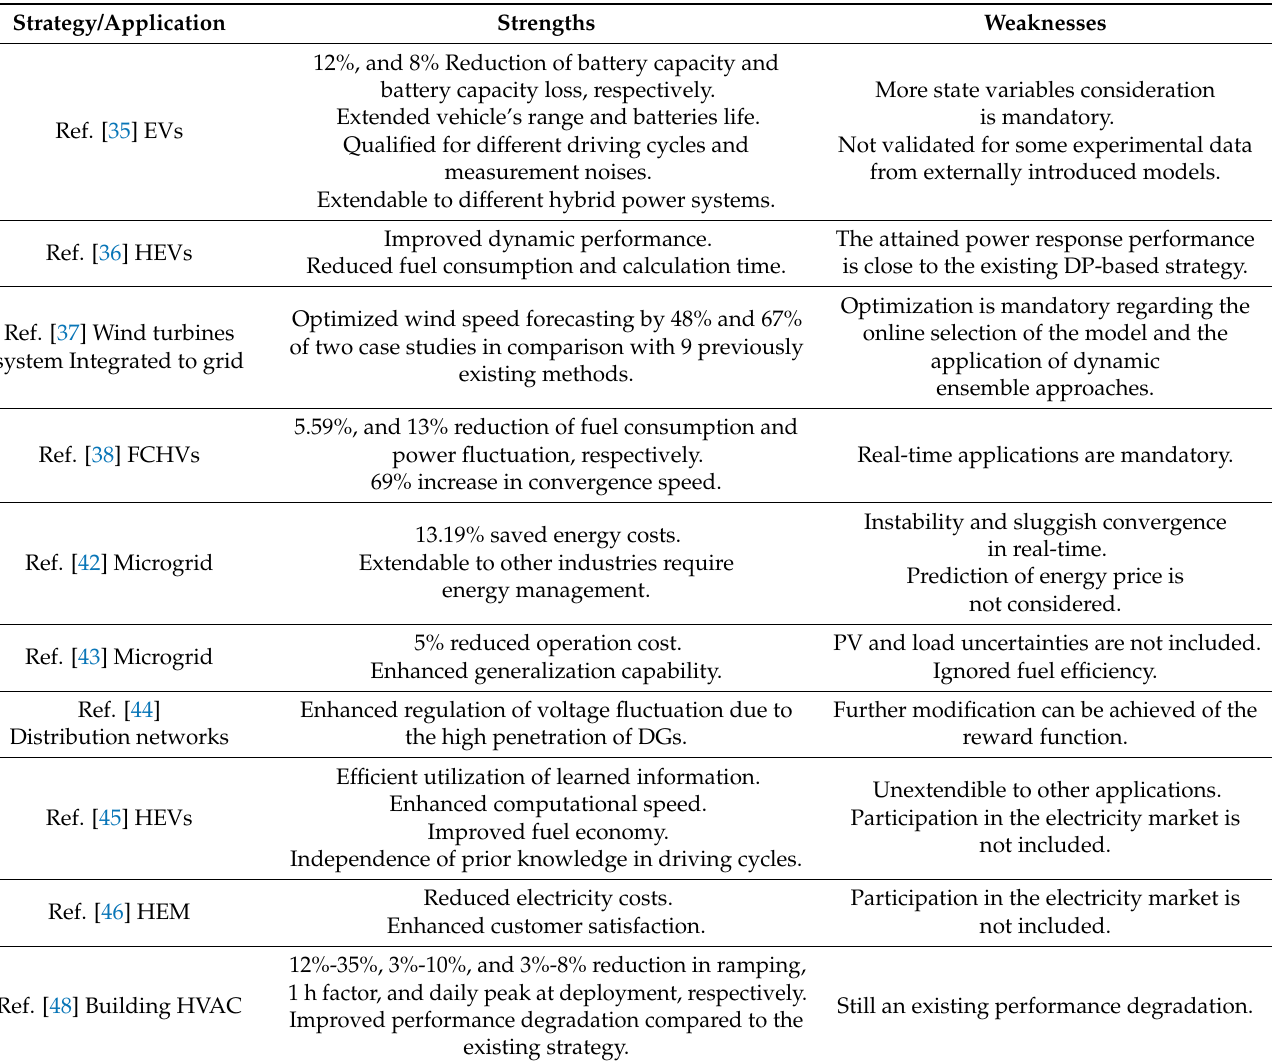
Table 1. Summary of the classical RL-based solutions of power flow management problems.